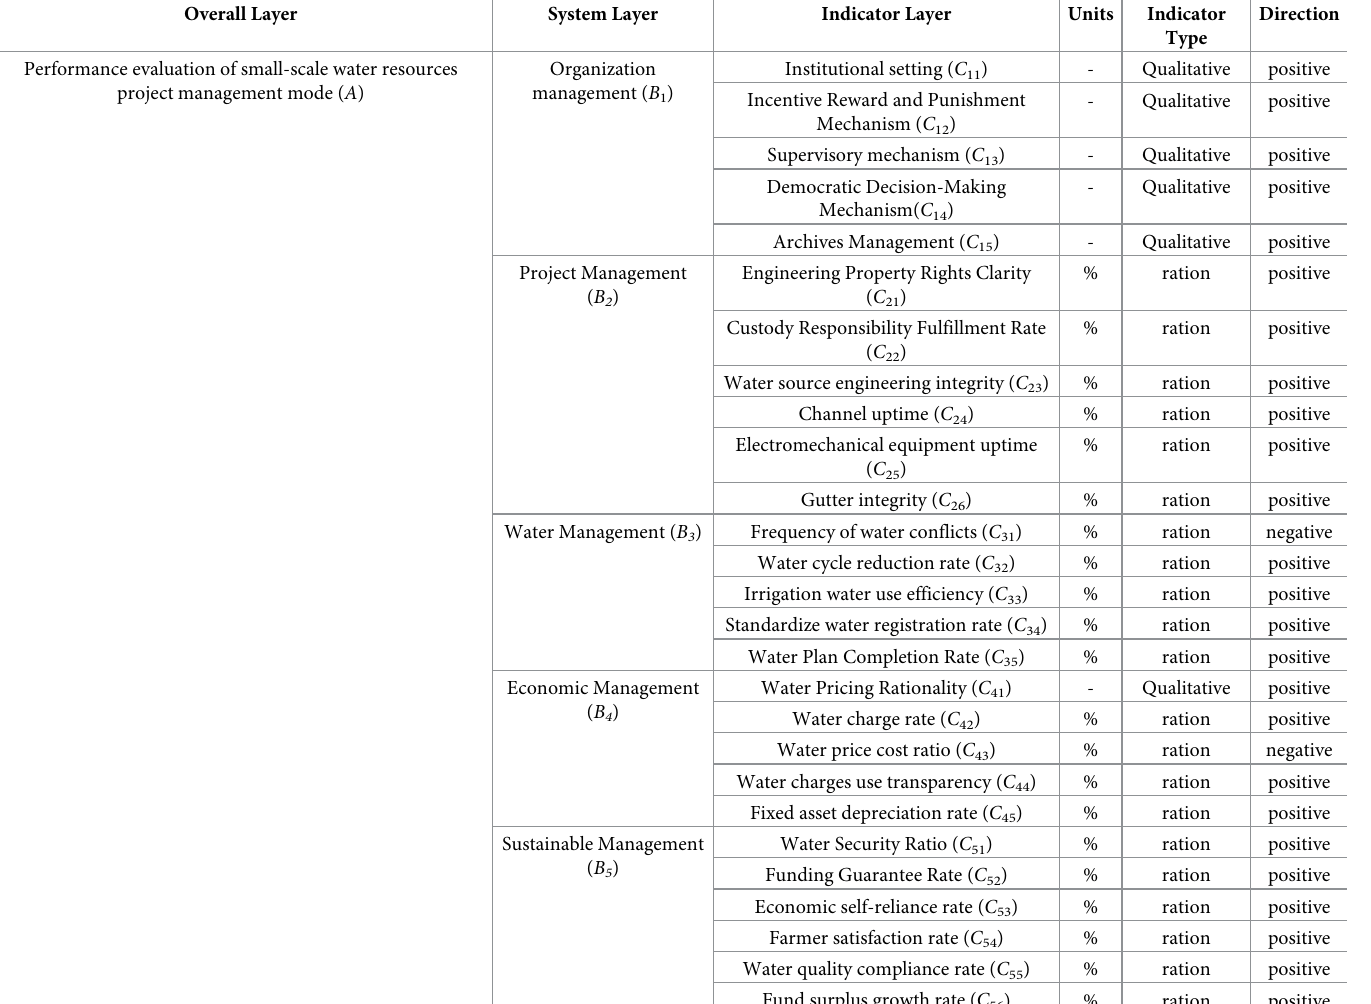
Table 1. Performance evaluation system of management mode of small-scale water resources projects. Overall